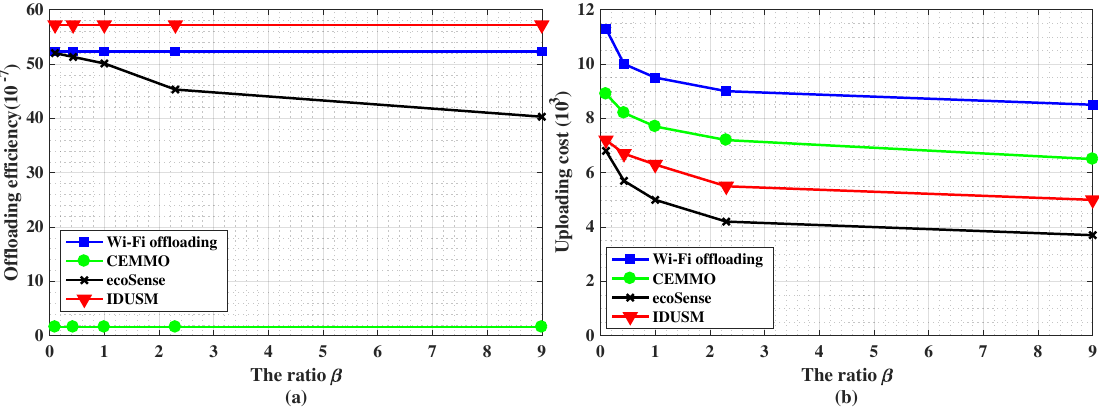
Figure 9. ( a ) The impact of the ratio β on offloading efficiency. ( b ) The impact of the ratio β on uploading